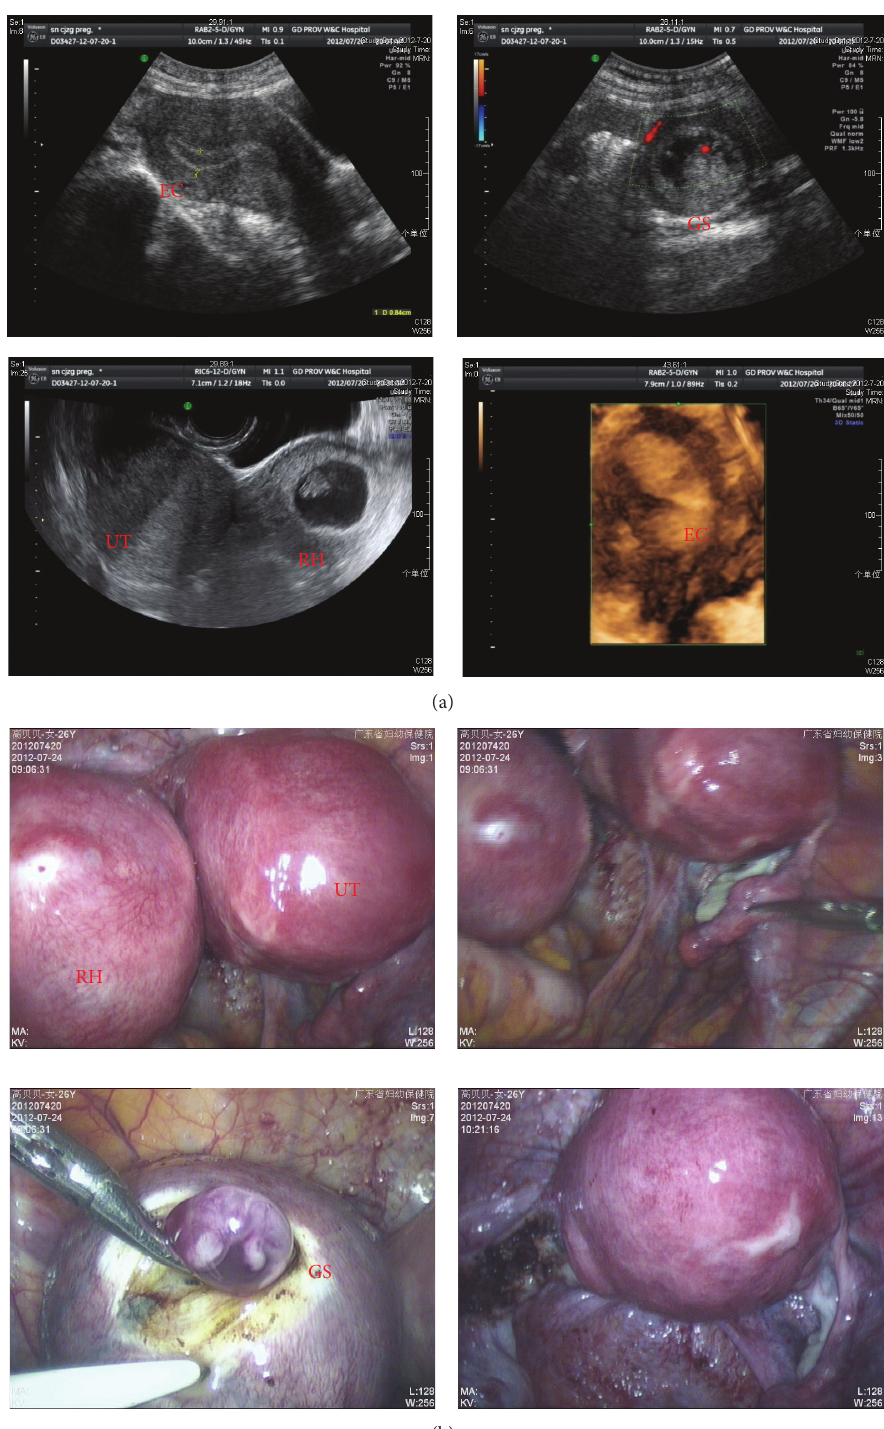
Figure 2: (a) Ultrasound revealed a right unicornuate uterus (UT) with an endometrial cavity (EC) and a noncommunicating rudimentary horn (RH) with a gestational sac (GS). There is an embryo (E) in the gestational sac with visible fetal heart beat. (b) Laparoscopy findings showing a left noncommunicating rudimentary uterine horn attached to a normal right